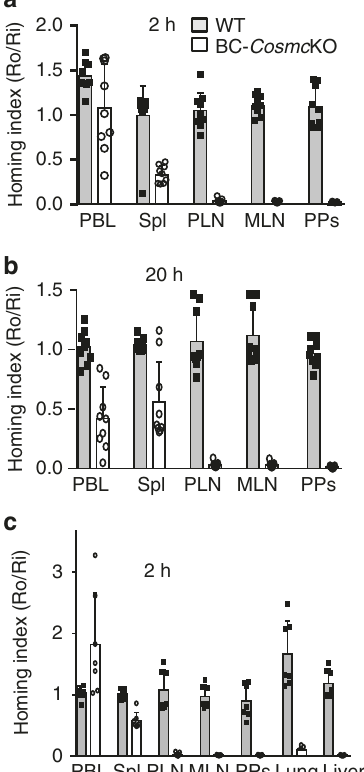
Fig. 3 Cosmc de fi ciency in B cells blocks B cell homing. Splenic cells from WT and BC- Cosmc KO mice were labeled with CellTrace Violet then transferred to WT mice separately ( n = 9), or mixed and co-transferred to WT ( n = 7) recipient mice with CFSE-labeled WT splenocytes as an internal control. Each symbol (black square and open circle for WT and BC- Cosmc KO, respectively) represents an individual mouse. Homed donor Tn − or Tn + B220 + (or CD19 + ) B cells were harvested at 2 ( a , c ) or 20 h ( b ) and analyzed by fl ow cytometry. The homing index was calculated as the [percentage of dye + Tn − or Tn + B cells] tissue /[percentage of internal control dye + B cells] tissue ratio to the input ratio. Data are presented as average ± SD of each genotype with each individual value plotted. Source data are provided as a Source Data fi